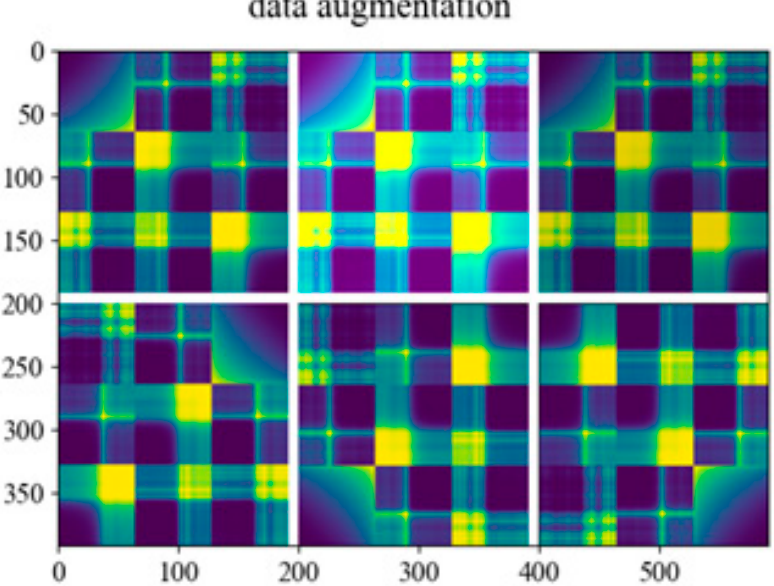
Figure 8. A two-dimensional combined image with enhanced data from a single gas sample. The x and y axis represent the number of pixels converted from the gas sensing response data to the gas sensing image.